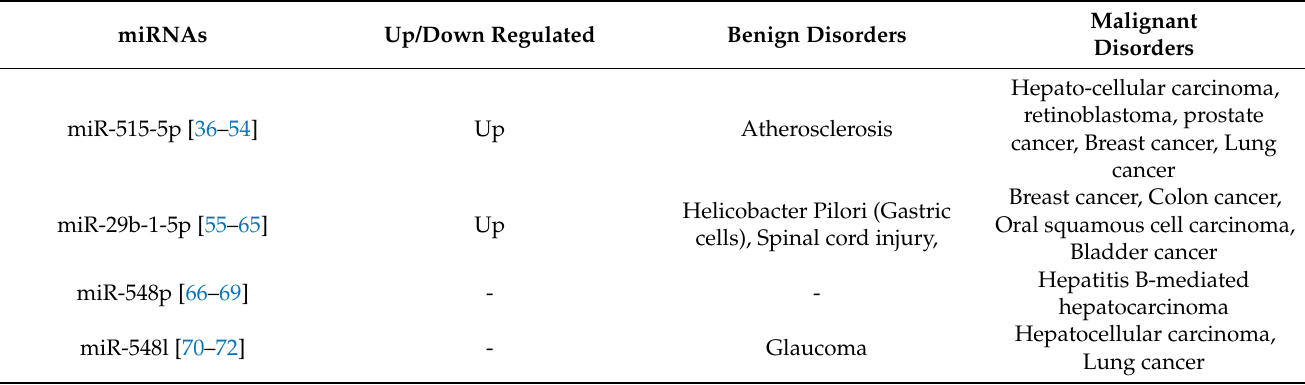
Table 2. miRNAs-associated benign and malignant